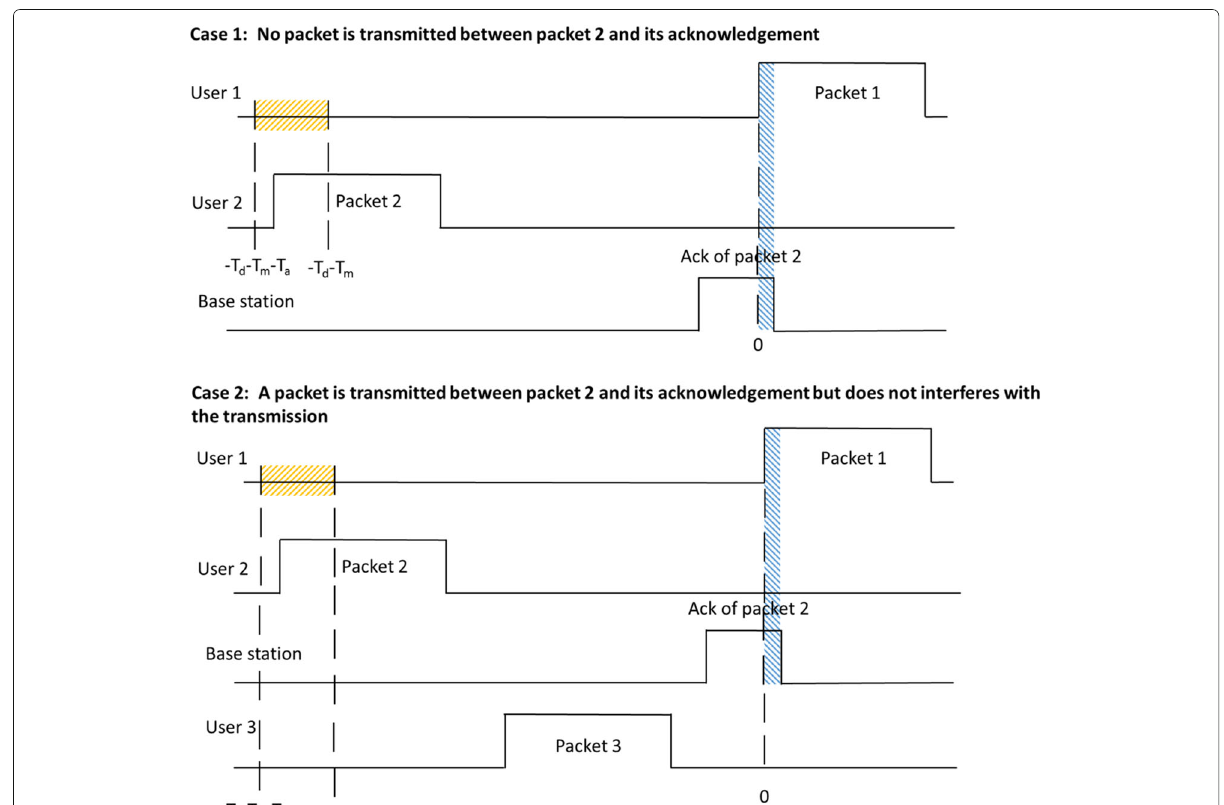
Fig. 8 The two incompatible cases which lead to a collision with a downlink packet without collision with an uplink packet